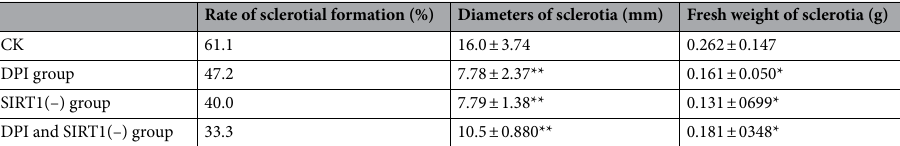
Table 1. Statistic results of sclerotia after added inhibitors. SIRT (–) mean added SIRT inhibitor sirt1720 hydrochloride. * and ** represented there were difference and significant difference between the group with